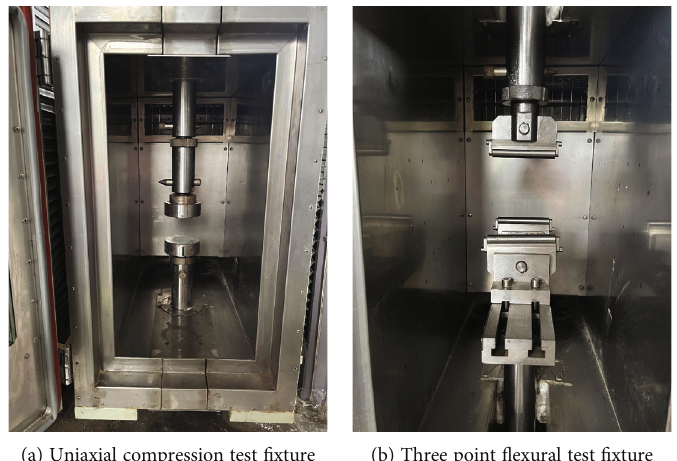
Figure 1: Loading pressure head of the frozen soil test system.